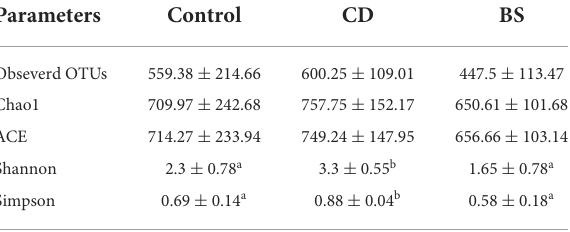
TABLE 1 The α -diversity index of intestinal microbiota in Pengze crucian